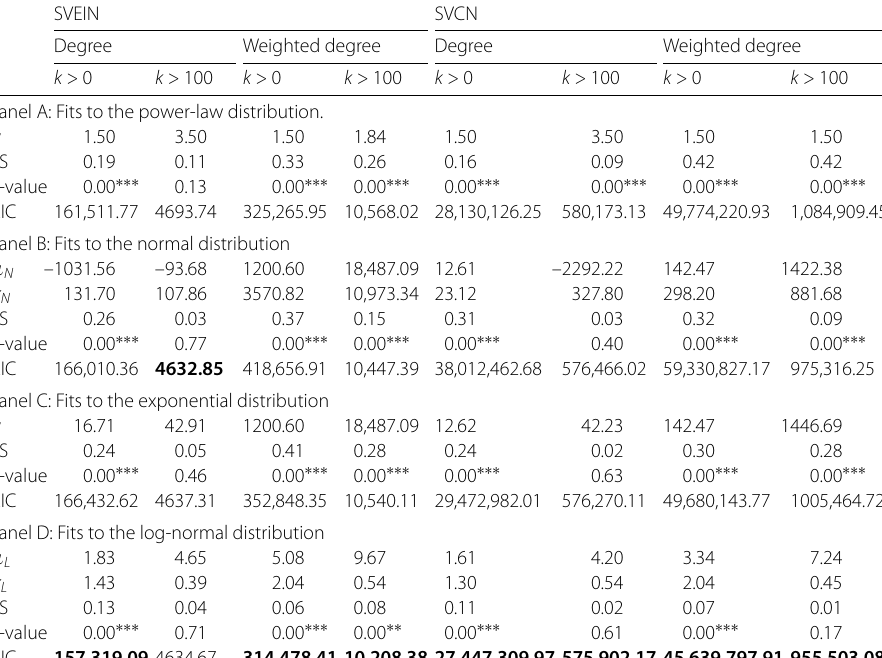
Table 2 Results of fitting the (weighted) degrees to the power-law, normal, exponential, and log-normal distribution for the SVEIN and SVCN and statistically testing on whether the (weighted) degrees are drawn from the four distributions. The symbols ∗ , ∗∗ , and ∗∗∗ indicate the significant levels of 5%, 1%, and 0.1%,